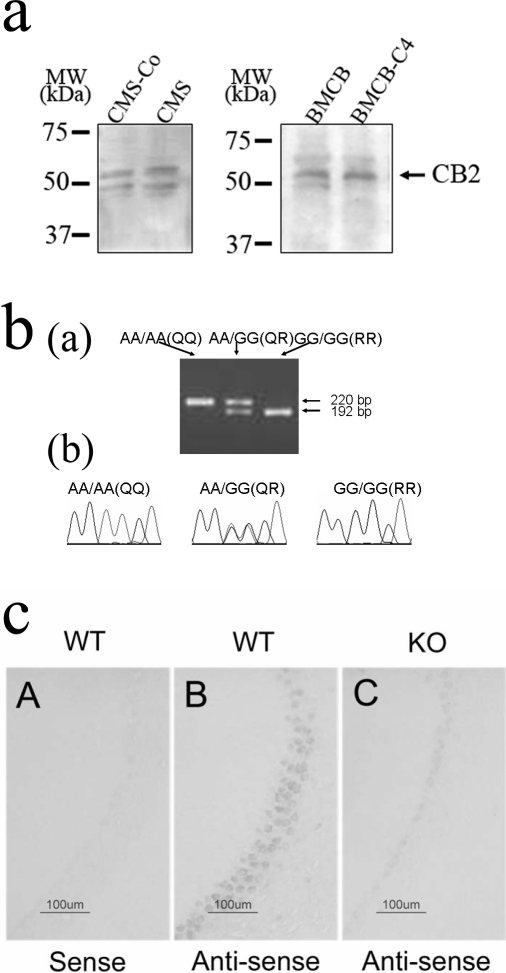
Brain CB2-Rs: Immunoblots, genotyping and in-situ hybridization.
A, In-situ hybridization indicating CB2 gene is expressed in the cerebellum of wild type and not in the cerebellum of the CB2-R deficient mice and also in sense controls in the wild type mice. B, RFLP genotyping discrimination on agarose gel for CB2 Q63R polymorphism in depressed subjects (Ba) and, Resequences of CB2 Q63R polymorphism (Bb). C, Western blotting of CB2-Rs in CMS and control mice (left panel) and in right panel in mice exposed to 4 mg/kg capsaicin in utero.